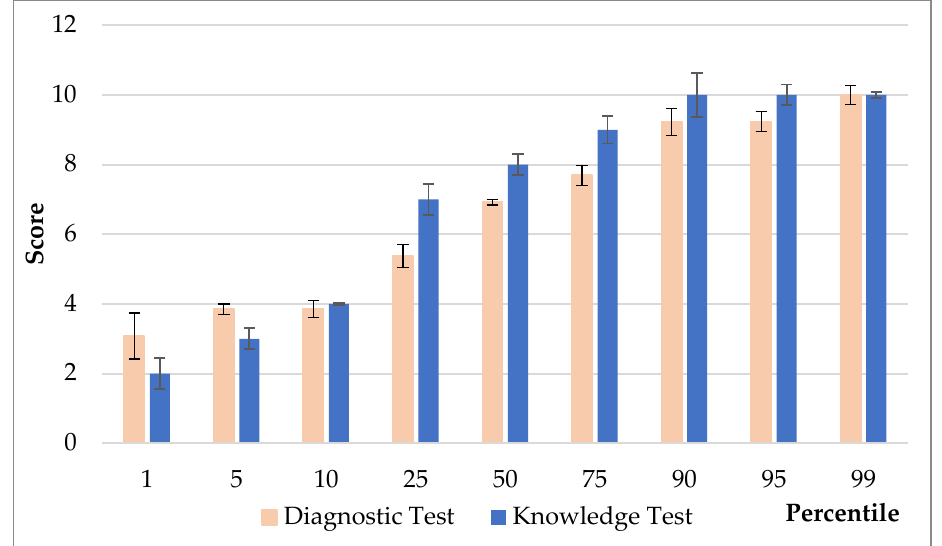
Figure 8. Percentile distribution of the students ’ grades during the knowledge test, after the training activity.